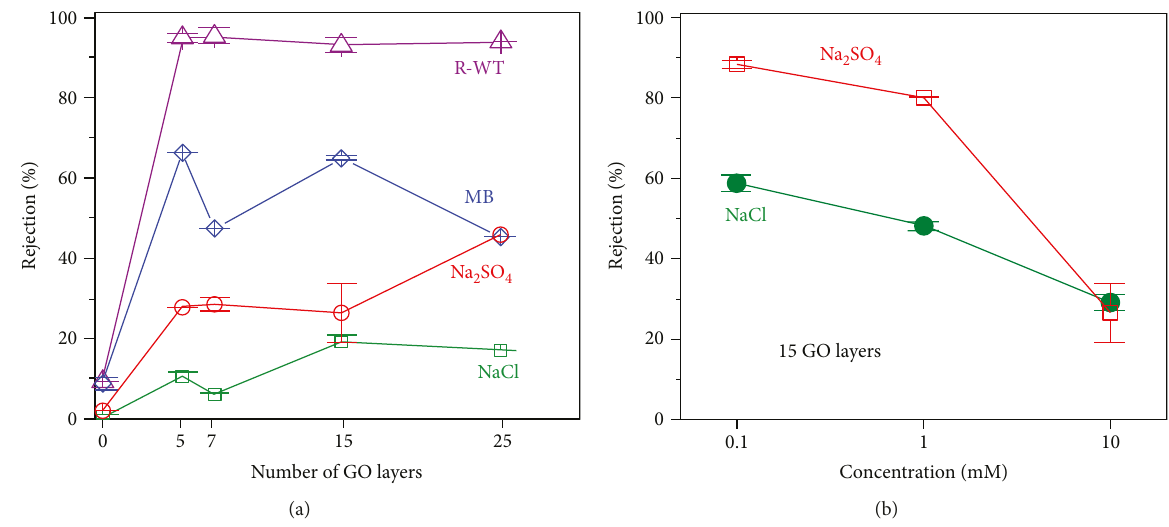
Figure 7: Various fi ltration results using GO membranes: rejection of salts and organic dyes with di ff erent numbers of GO layers (a) and e ff ect of salt concentration on the rejection by the 15-layered GO membrane (b). The data at 0 layer are those of the polydopamine-coated membrane. All rejection tests were performed under 50psi (0.34MPa) and the rejection tests in (a) were performed with 20 mM NaCl, 10mM Na2SO4, 7.5mg/LMB, and 7.5mg/L R-WT solutions, respectively. Reprinted with permission from [71]. Copyright (2013) American Chemical